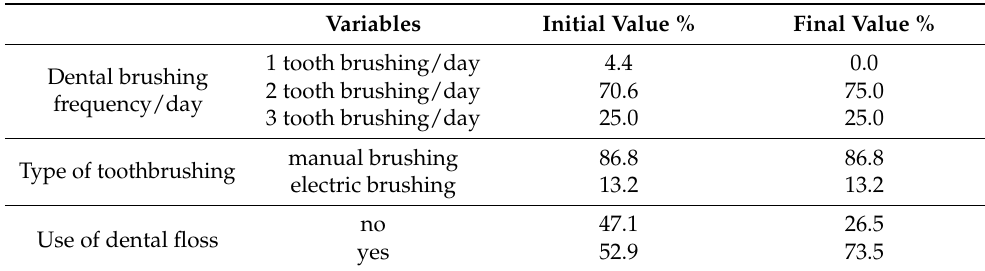
Table 5. Assessment of healthy attitudes and behaviors before and after the